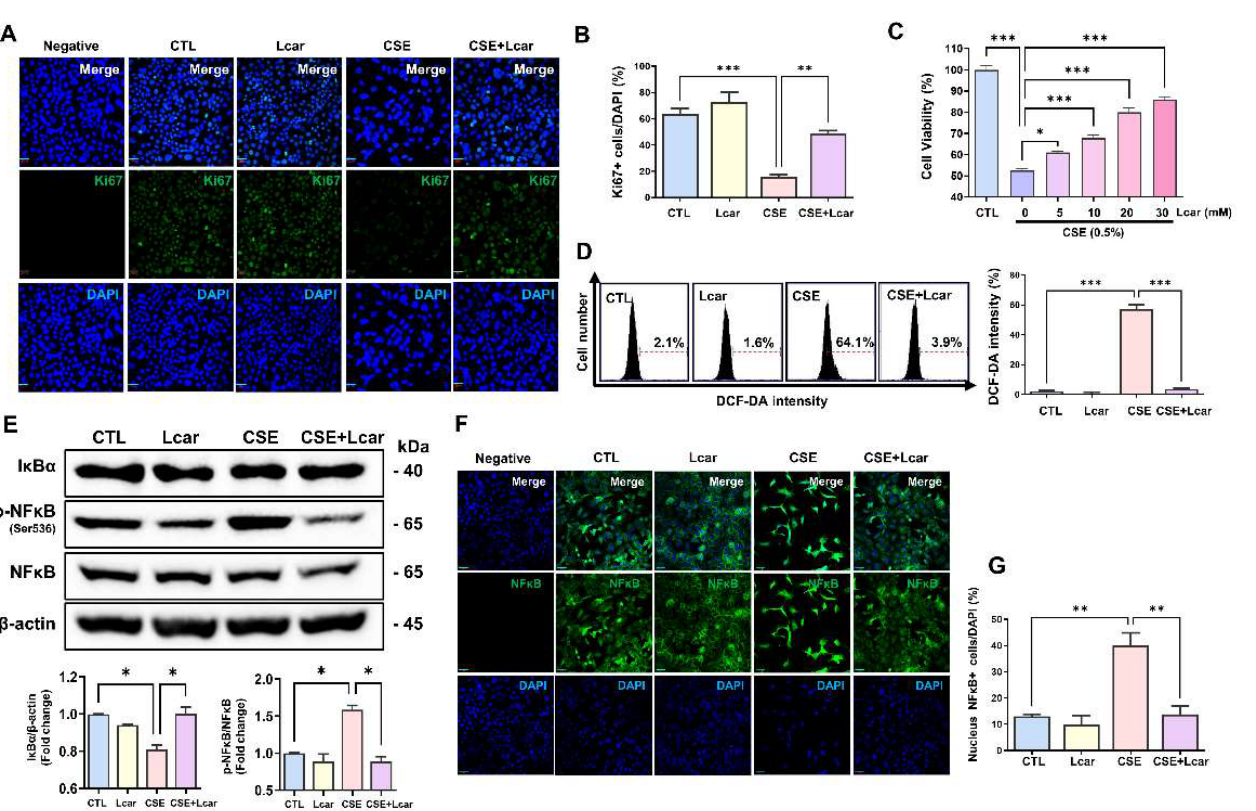
Figure 6. L-carnosine rescued alveolar epithelial cells in cigarette smoke extract exposure by inhibiting ROS production through diminishing NFκB signaling pathway. Mouse lung epithelial cell (MLE12) was exposed to 0.25% cigarette smoke extract for 24 h. At the same time, L-carnosine (5 mM~30 mM) was co-treated. ( A ) Representative images of immunocytochemistry assay. Ki67 was labeled by GFP. ( B ) Relative fluorescence intensity ratio graph of Ki67 ( n = 3/group). ( C ) Cell viability was measured by MTT assay ( n = 4/group). ( D ) Representative images of DCF-DA assay. ROS generation was measured by DCF-DA assay, and relative fluorescence intensity ratio graph of DCF-DA ( n = 3/group). X axis means FL-A and y axis means count of cells. ( E ) Protein expression of NFκB and IκBα was measured by Western blot. Relative density ratio graph of NFκB and IκBα. IκBα was divided by β-actin and p-NFκB was divided by NFκB ( n = 3/group). ( F ) Representative images of immunocytochemistry assay. NFκB was labeled by GFP. ( G ) Nucleus NFκB+ cell was divided by DAPI ( n = 3/group). A value of * p < 0.05, ** p < 0.01, and *** p < 0.001 was compared with each indicated group by one-way ANOVA. CTL, Control; L-car, L-carnosine; CSE, Cigarette smoke extract. Scale bar: 30 μm.